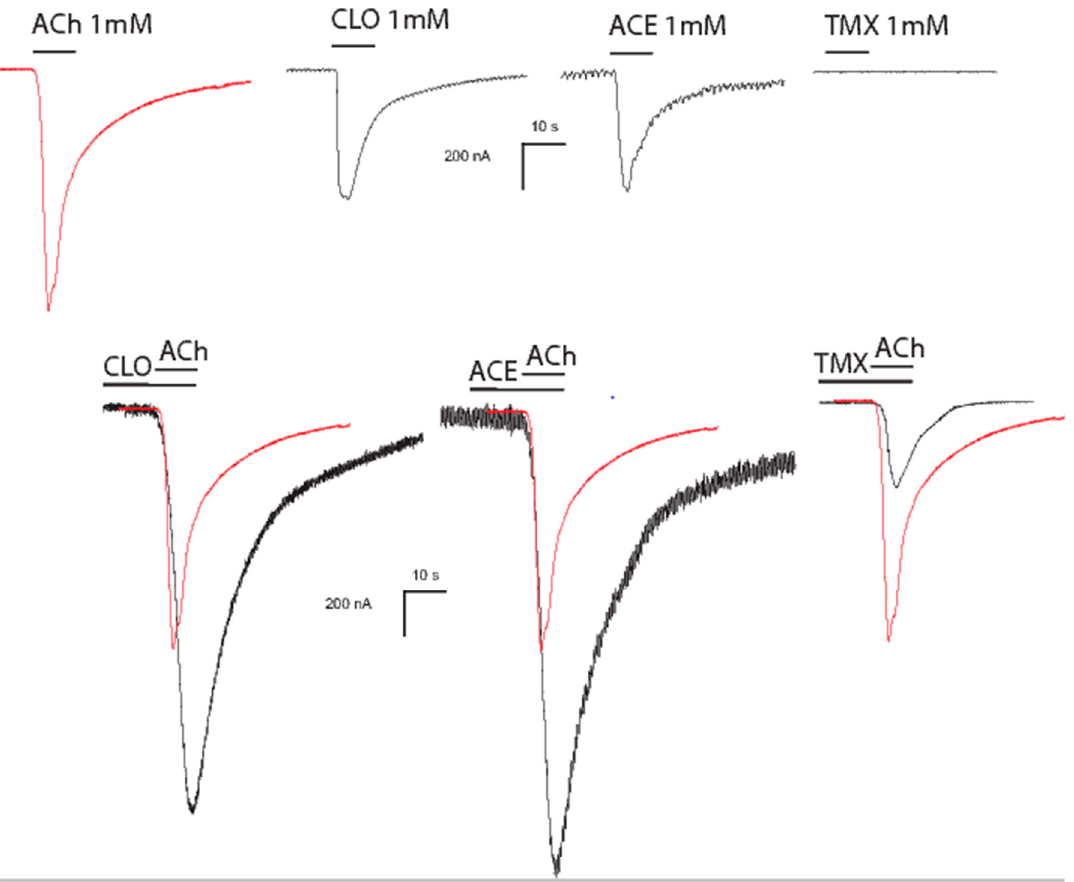
Figure 2. E ff ects of neonicotinoids on ACh-evoked current amplitudes. Clothianidin (CLT) and acetamiprid (ACE) enhance ACh-induced current amplitudes of the mammalian α 7 neuronal nAChRs and thiamethoxam (TMX) decreases ACh-induced current